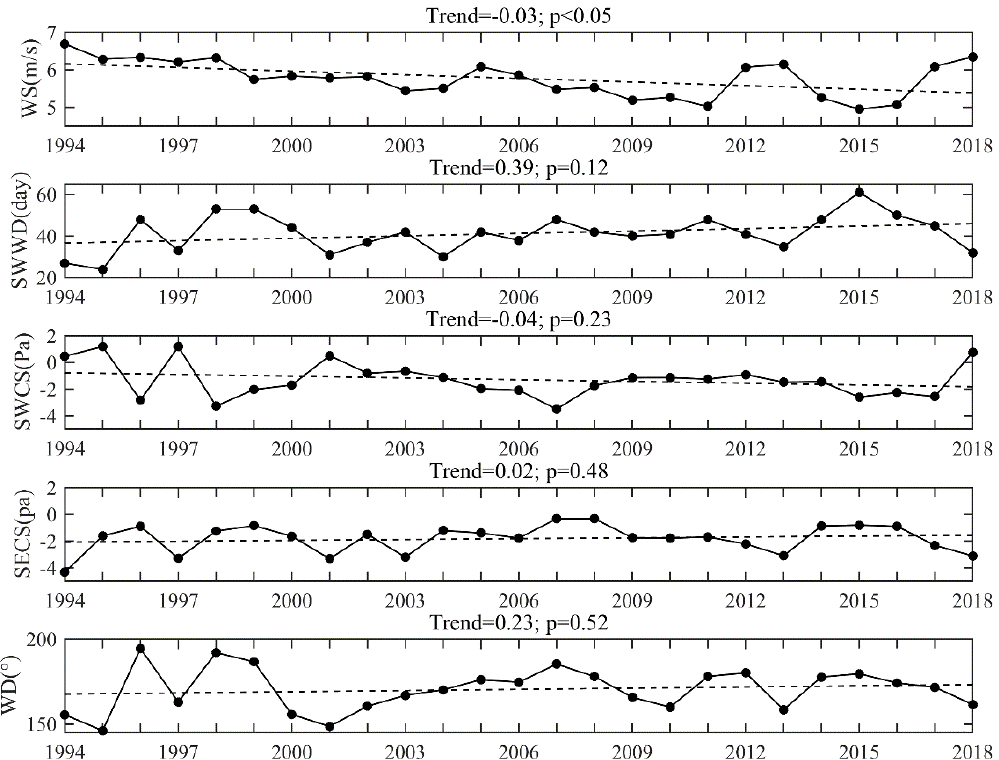
Figure A2. Average wind speed (WS), southwestern wind duration (SWWD), southwestern wind cumulative stress (SWCS), southeastern wind cumulative stress (SECS), average wind direction (WD) in summer, and their long-term trends during 1994–2018. Note that the negative values of SWCS and SECS represent southwestern and southeastern wind, respectively. The trends and significant p values are shown in the title of each